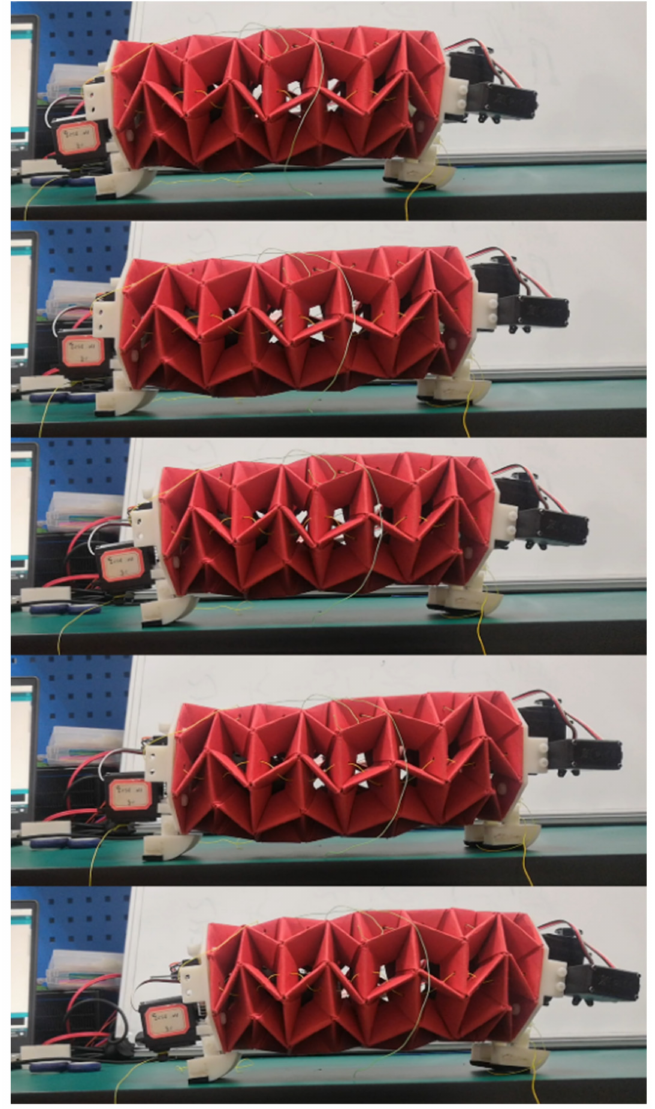
Figure 17. Forward motion of the origami robot with rubber sliding feet on a wooden